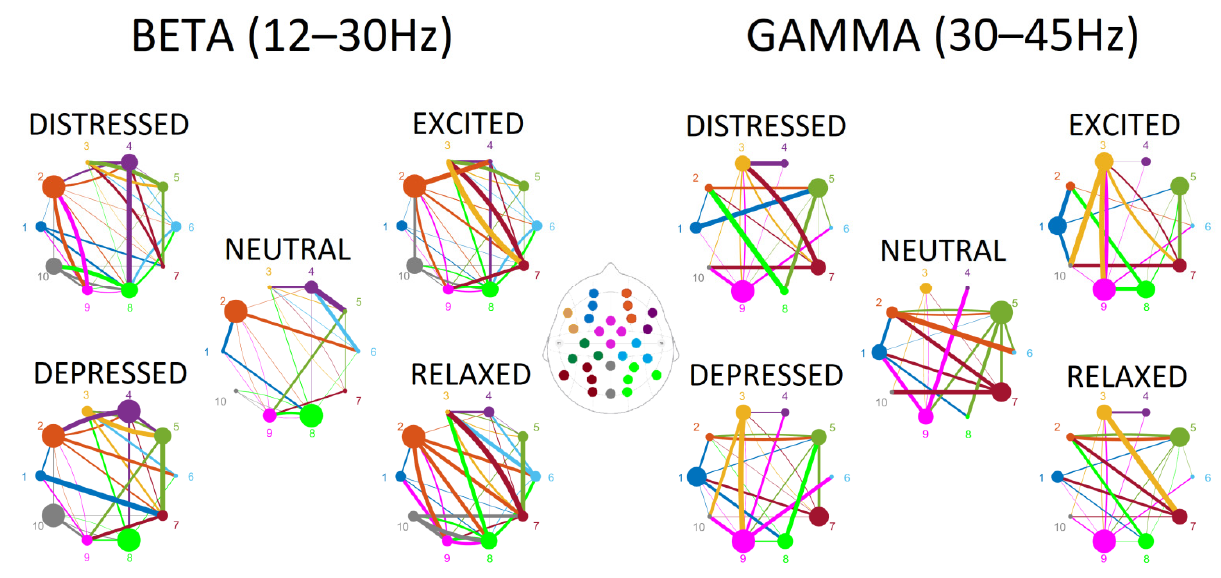
Figure 3. The connectivity plots in the beta and gamma frequency ranges for five experimental conditions—neutral, depressed, distressed, excited, and relaxed performance instructions. Colors represent ROIs (also coded as numbers: mid-frontal left (1) and right (2), fronto-lateral left (3) and right (4), centro-parietal left (5) and right (6), parieto-occipital left (7) and right (8), fronto-central (9) and central parieto-occipital (10)) and corresponding connections from each ROI. The size of the circle reflects the degrees of nodes, and the thickness of the lines reflects the strength of the connection.